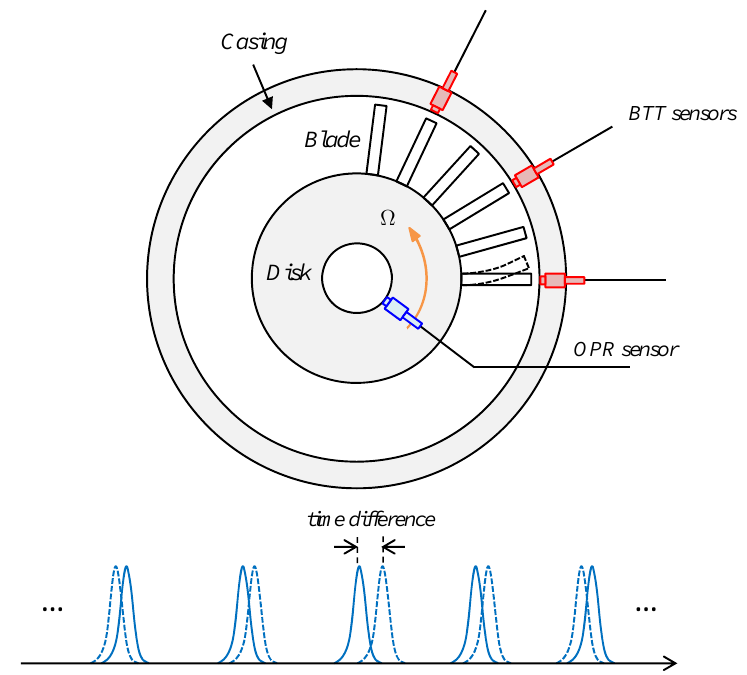
Figure 1. Principle of the Blade Tip-Timing (BTT) method (solid line: non-vibrating blade, dashed line: vibrating